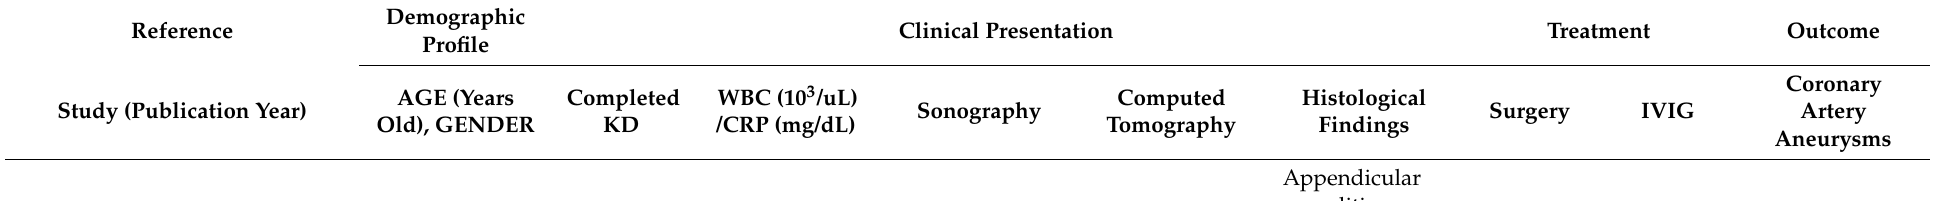
Table 1. Clinical characteristics of Kawasaki Disease mimicking appendicitis in 13